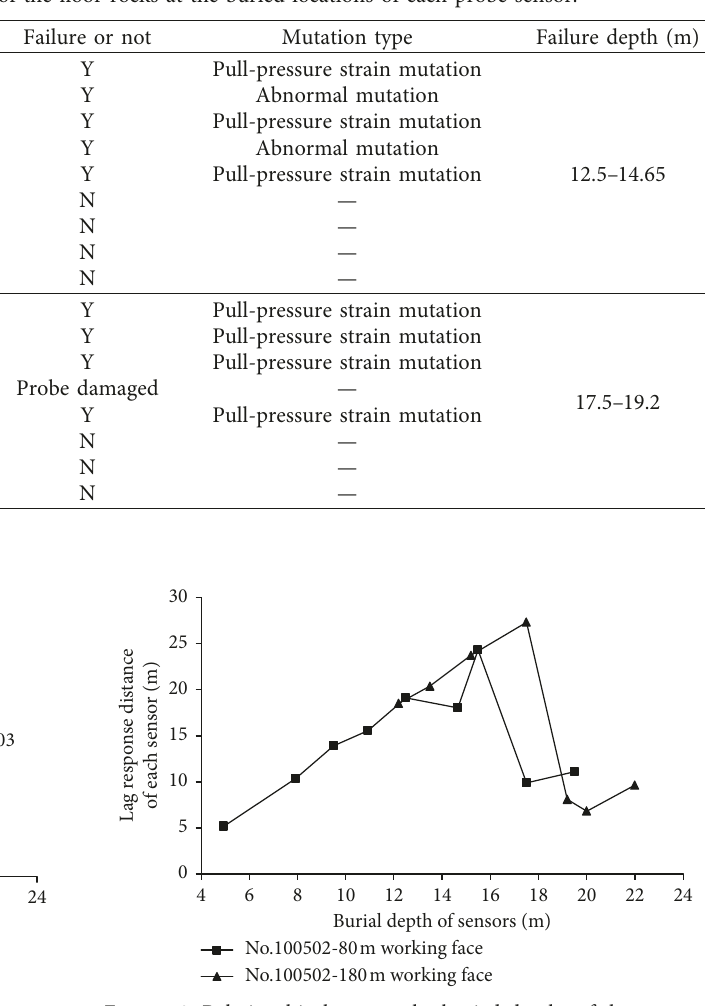
Figure 7: Relationship between the buried depths of the sensors and their advanced response distances.